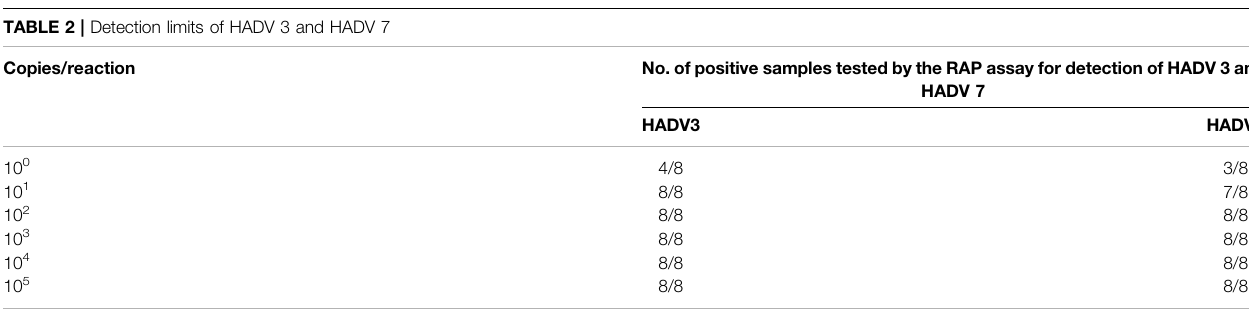
TABLE 2 | Detection limits of HADV 3 and HADV 7 Copies/reaction